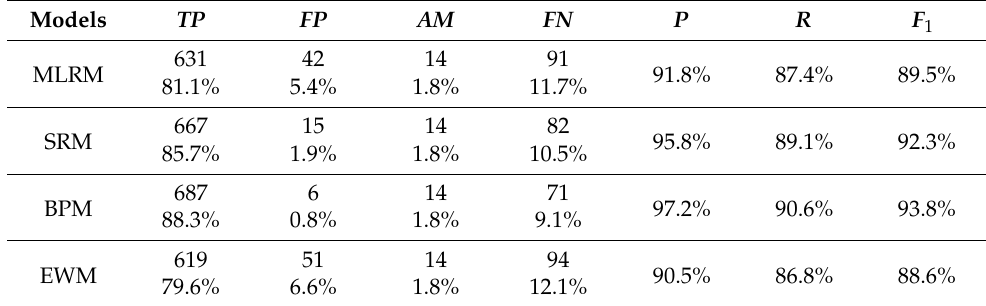
Table 4. Matching results of four matching models.